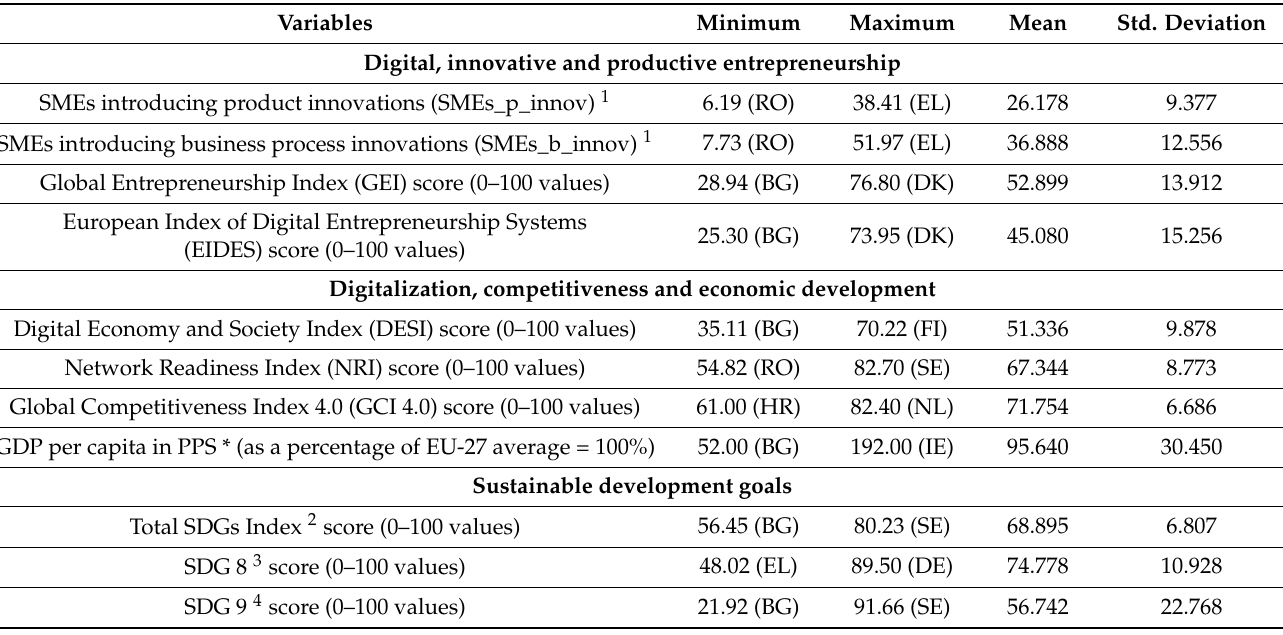
Table 1. Descriptive statistics ( n =